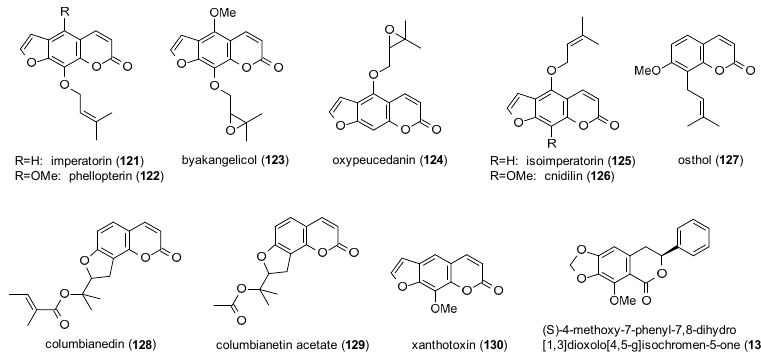
Figure 8. Chemical structures of coumarins with reported GABA(A)-receptor modulating activity.